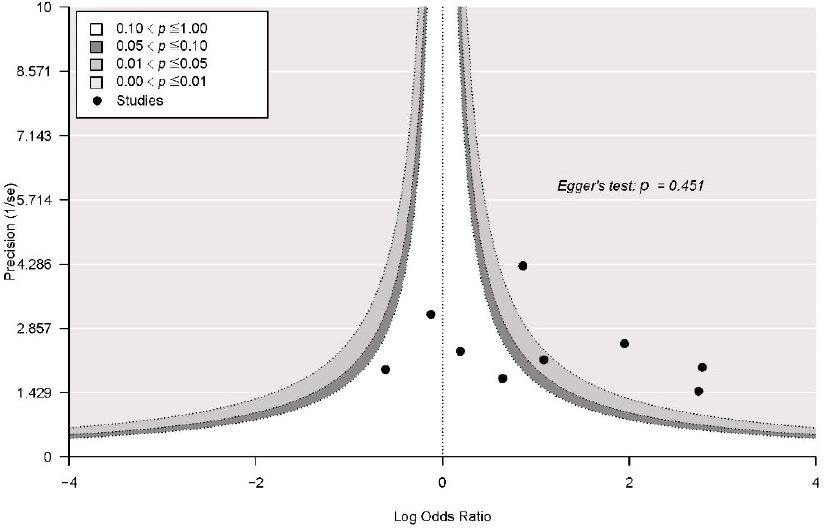
Figure 7. TSA of effect of concurrent VTI with palatal repair.